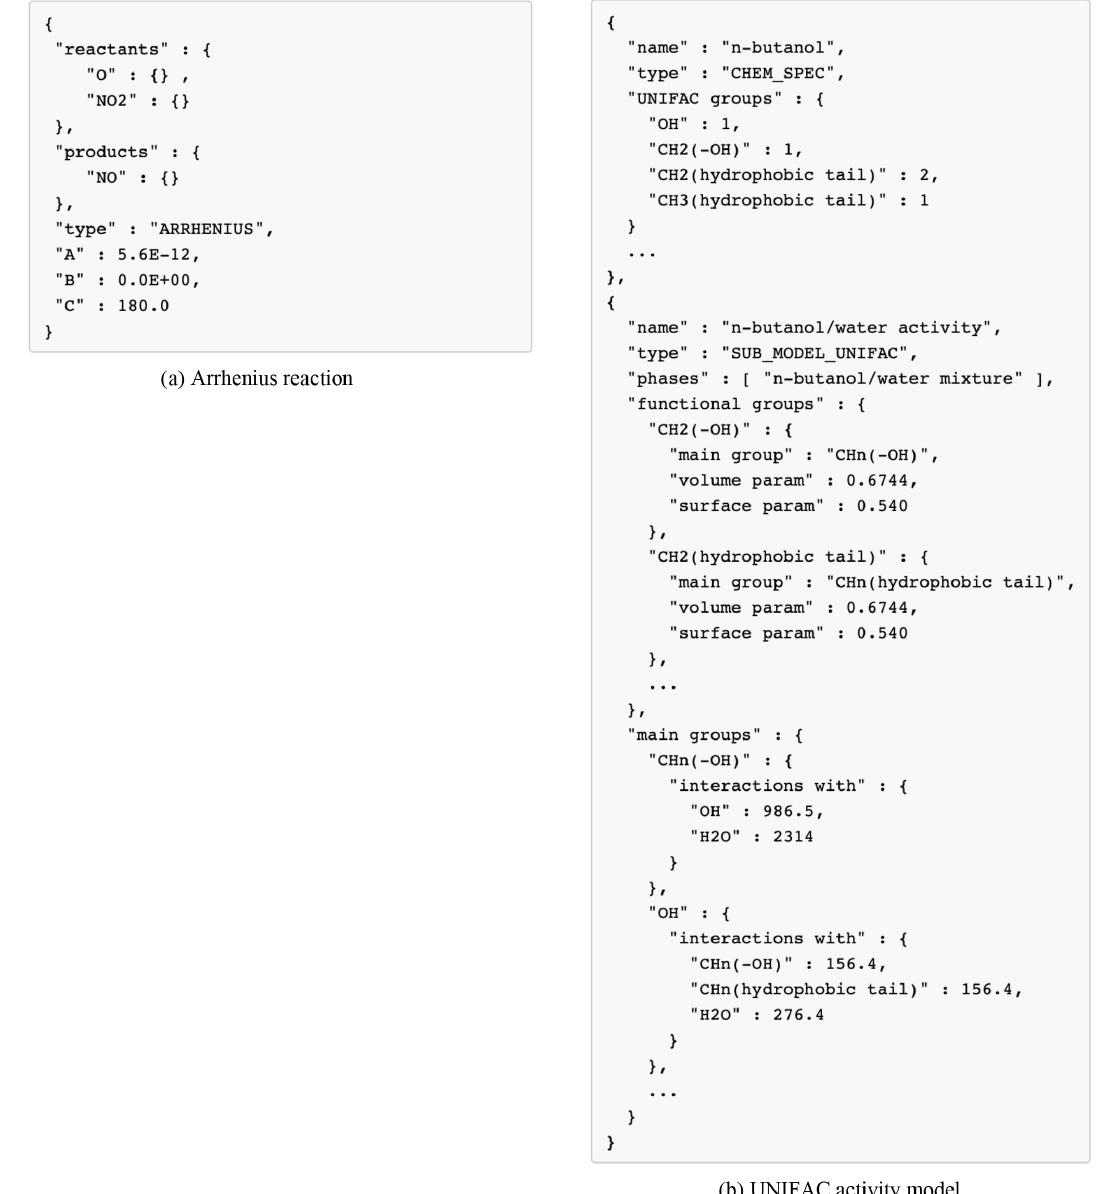
Figure 4. Two examples of CAMP configuration data in JSON format: an Arrhenius reaction (a) and a portion of a UNIFAC activity model configuration (b) . Ellipses (...) indicate portions of the data omitted for